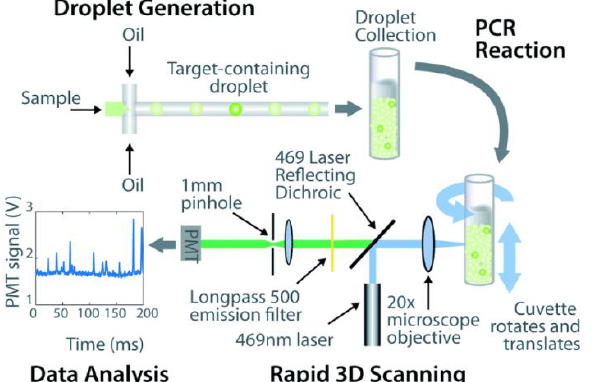
Figure 6. Workflow of IC3D ddPCR for clinical samples. Reproduced with permission from [78]. Sample is divided into millions of picoliter-sized droplets. After PCR amplification, target fluorescent droplets are transported across the excitation volume due to the slow vertical translation and fast rotation of the cuvette and finally quantified.